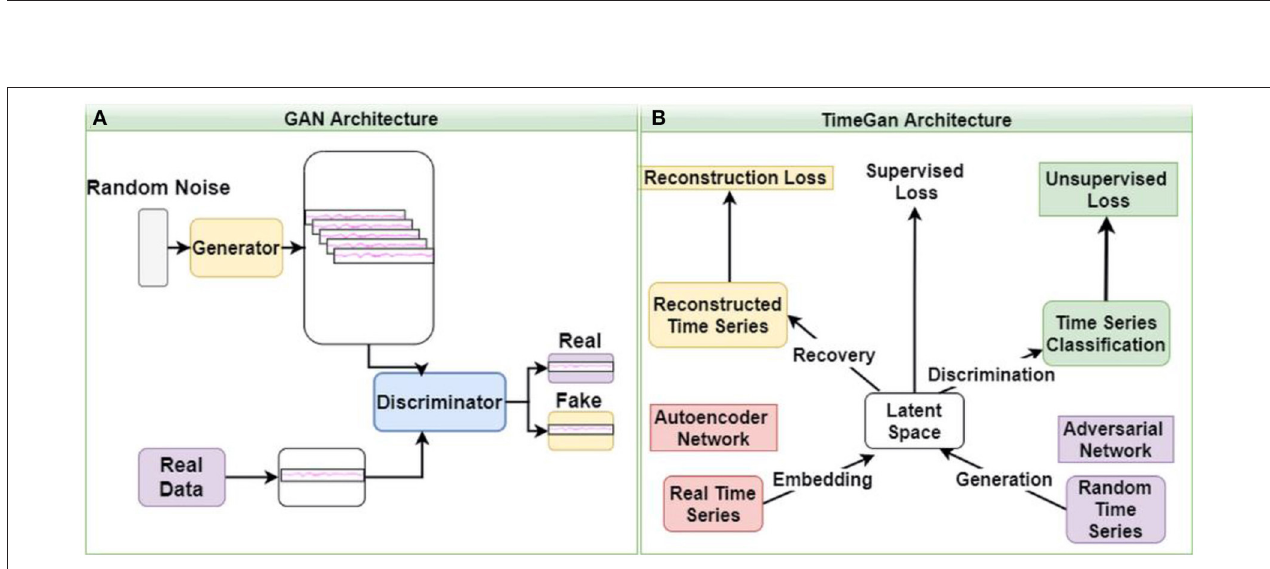
FIGURE 3 | The architecture of GAN (A) and time GAN (B) . (A) Generative Adversarial Networks (GAN) is an unsupervised learning system that involves discovering and learning the patterns in input data to generate a new set of synthetic data that mimics the original dataset. (B) Time-series Generative Adversarial Networks (Time-GAN) combines the flexibility of the unsupervised paradigm with the control by incorporating supervised training.